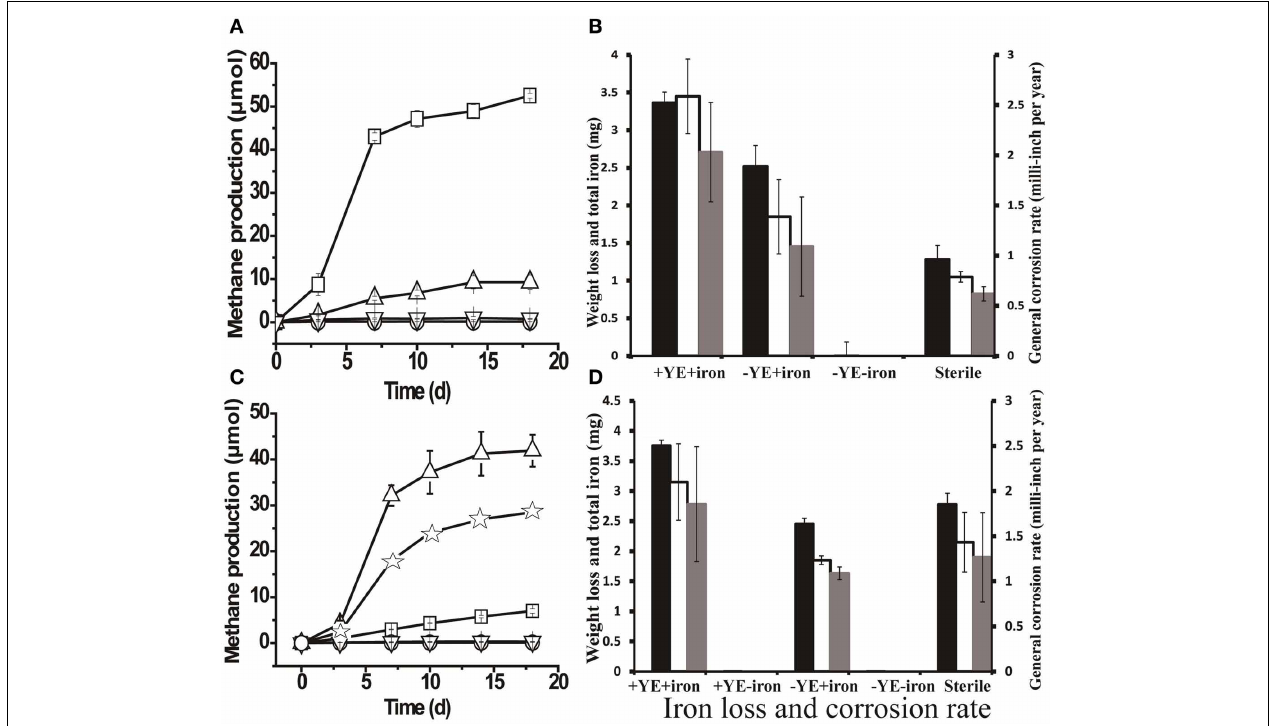
negative controls, active inocula without YE or the coupon and autoclaved inocula with YE and a coupon, respectively. (D) Weight loss and total iron released from coupon in the cultures of methanogenic enrichment after 6 transfers with iron granules. The black bars in Figures 4B,D indicate the corrosion determined by total iron analysis; the clear bars in Figures 4B,D represent the corrosion determined by weight loss; and the gray bars in Figures 4B,D are general corrosion rate calculated based on the weight loss data. + YE + iron: with both YE and coupon in the medium; Sterile: autoclaved inocula with both YE and coupon in the medium; − YE + iron: with only the coupon in the medium; − YE − iron: without YE or the coupon in the medium; + YE − iron: with only YE in the medium. The methane production ( µ mols) was calculated based on a 15-ml